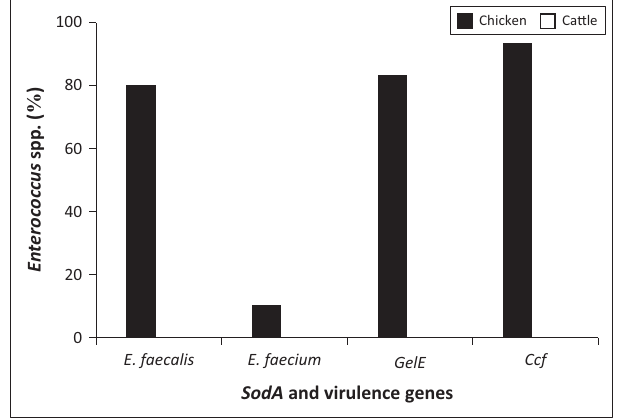
FIGURE 4: Prevalence of Enterococcus faecalis , Enterococcus faecium and virulence genes gelE and ccf in companion animals.